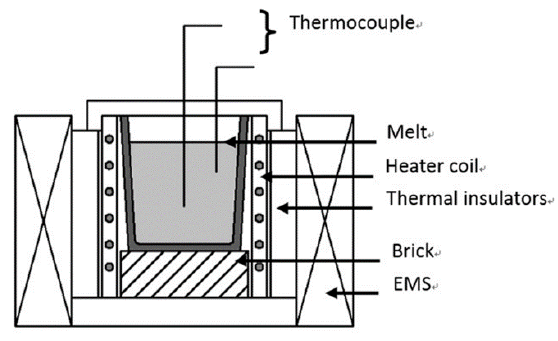
Figure 2. The diagram of electromagnetic stirrer. EMS: electromagnetic stirring.